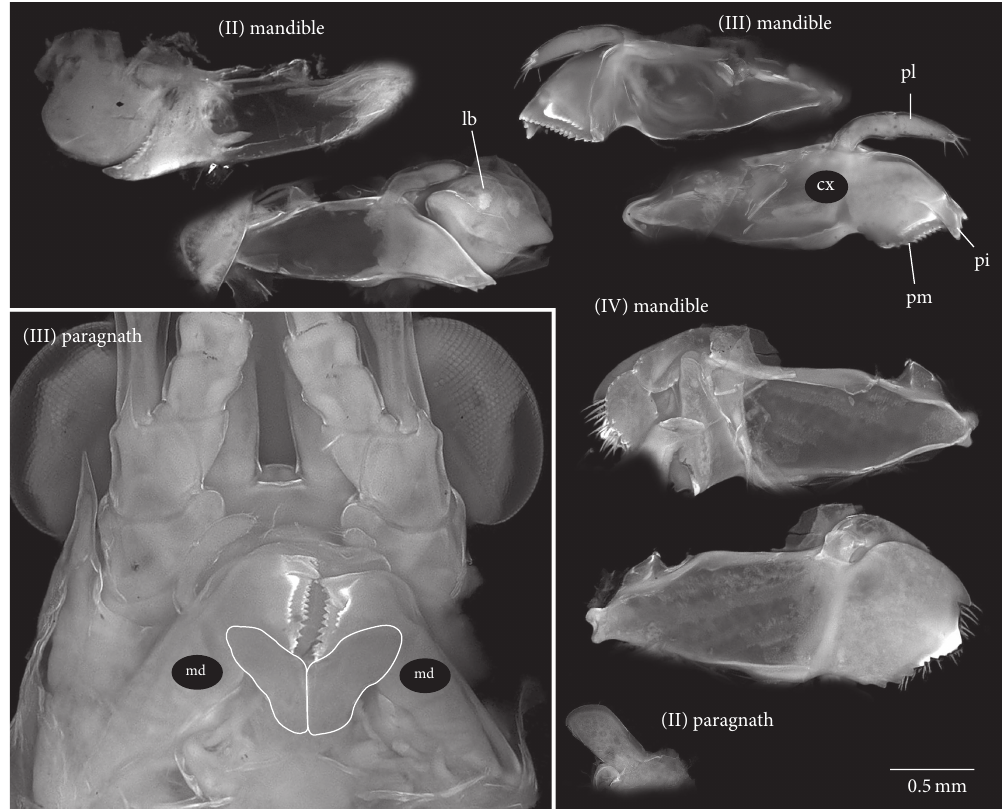
Figure 4: Mandible and paragnaths of larval stages (II) to (IV) of Homarus gammarus. Right mandible in anterior (top) and posterior view (bottom). Note that (II) mandible and (IV) mandible are left mandibles flipped, while (III) mandible is a right mandible. (II) Mandible is still attached to labrum. (III) Paragnath shown in situ, marked by hand due to low contrast against mandible. (II) Paragnath, right, in posterior view. lb = labrum; md = mandible; pi = pars incisivus; pl = palpus; pm = pars